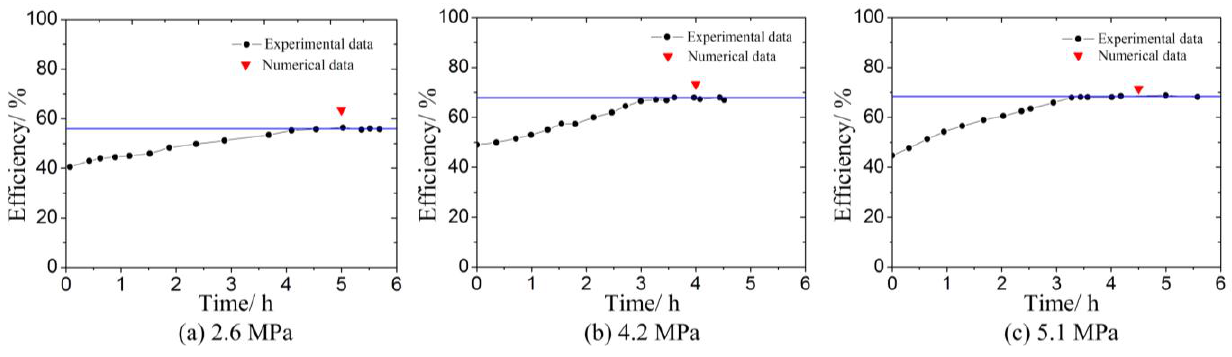
Figure 11. Comparison of experimental and numerical results.